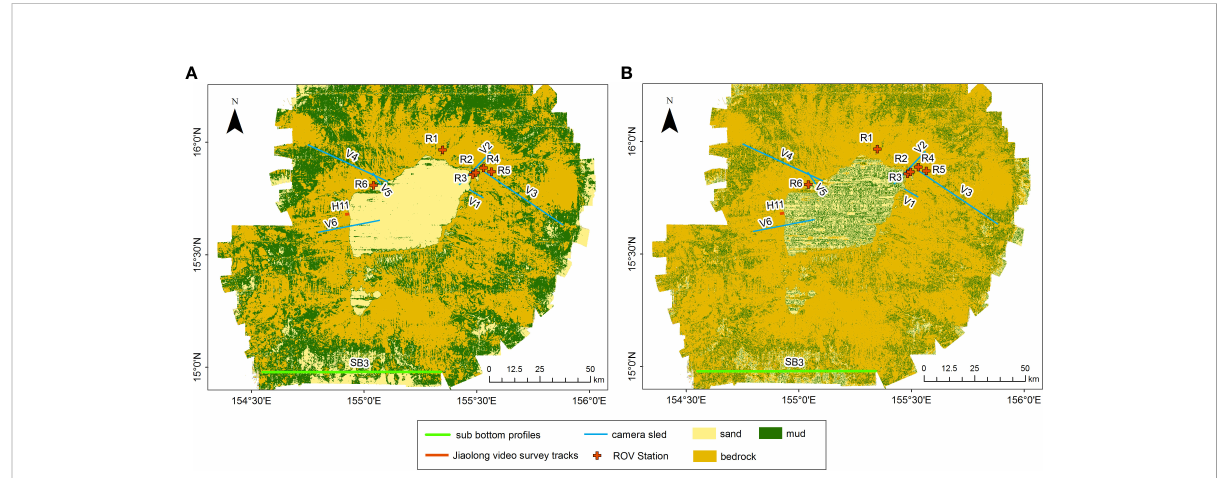
FIGURE 6 Textural results of the backscatter images [(the red crosses are remotely operated vehicle (ROV) stations]: (A) maximum likelihood classi fi cation. (B) Random forest classi fi